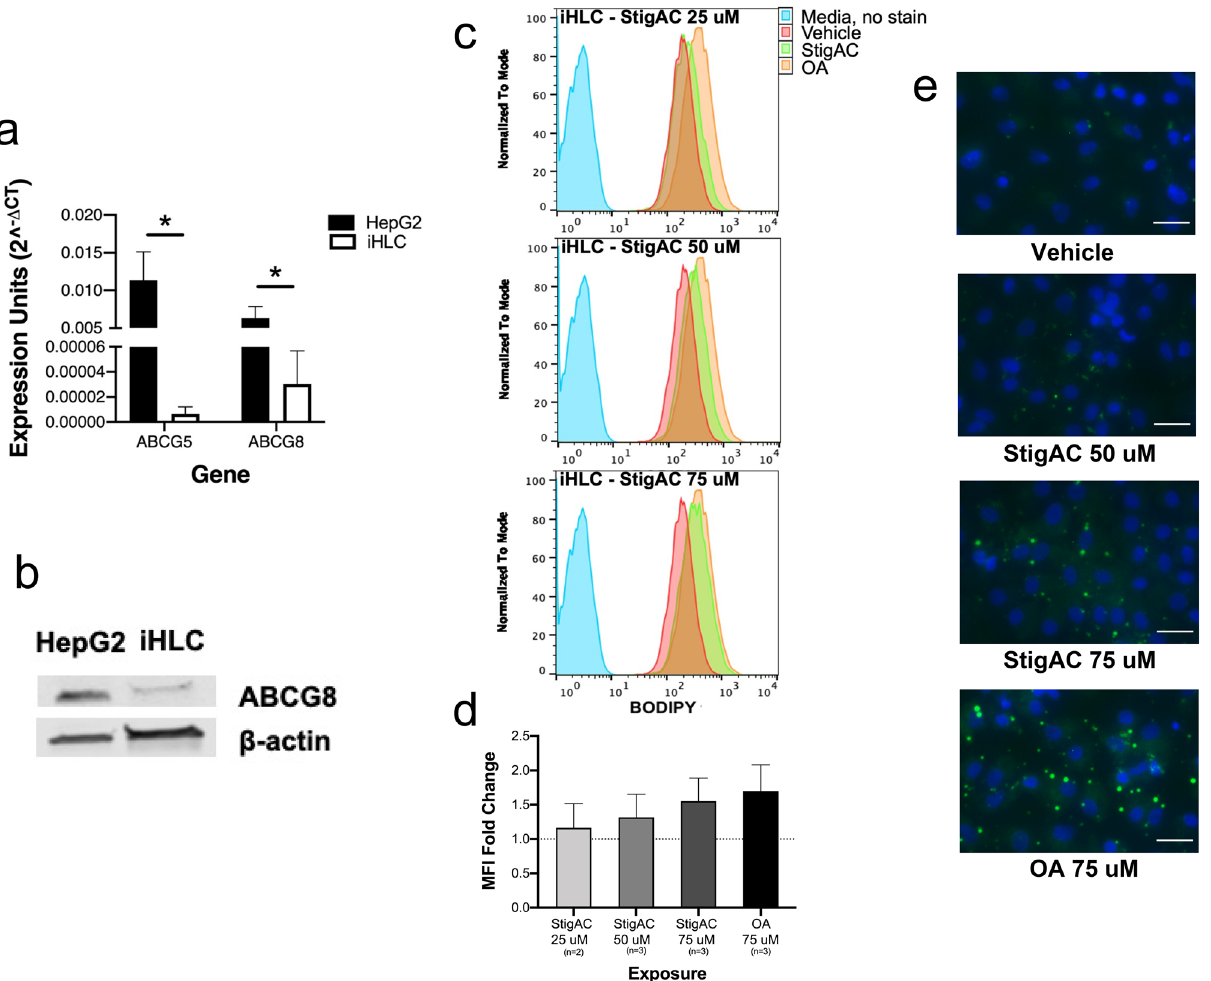
Figure 3. ABCG5 and ABCG8 expression and lipid accumulation in iHLC exposed to stigmasterol (StigAC). ( a ) Bar graph showing baseline mRNA levels, by real-time qRT-PCR, of ABCG5 and ABCG8 genes in iHLC (white) compared to adult-derived HepG2 hepatocytes (black). Expression units (2 -ΔCT ) was calculated relative to the housekeeping reference gene, β-actin. N = 3 biological replicates each for iHLC and HepG2 cells. Error bar indicates standard deviation (SD). * P -value < 0.05. ( b ) Western blot for baseline ABCG8 protein expression in iHLC and HepG2 cells. ( c ) Representative flow cytometry profile showing the fluorescence of BODIPY in iHLC exposed to increasing concentrations of 25, 50, and 75 μM of StigAC (green), compared to iHLC exposed to vehicle alone (red) and the positive control iHLC exposed to oleic acid (OA) (orange). ( d ) Bar graph showing the BODIPY median fluorescence intensity (MFI) of StigAC-exposed cells relative to the MFI of cells exposed to vehicle alone (dotted line). N = 3 independent experiments in all exposures with the exception of n = 2 for the StigAC 25 μM exposure experiment. Error bar indicates standard deviation (SD). ( e ) Immunocytochemistry showing intracellular lipid droplets in iHLC exposed to 50 μM and 75 μM StigAC compared to iHLC exposed to vehicle alone and the positive control (OA). Scale bar: 25 μm. StigAC, stigmasterol acetate; OA, oleic